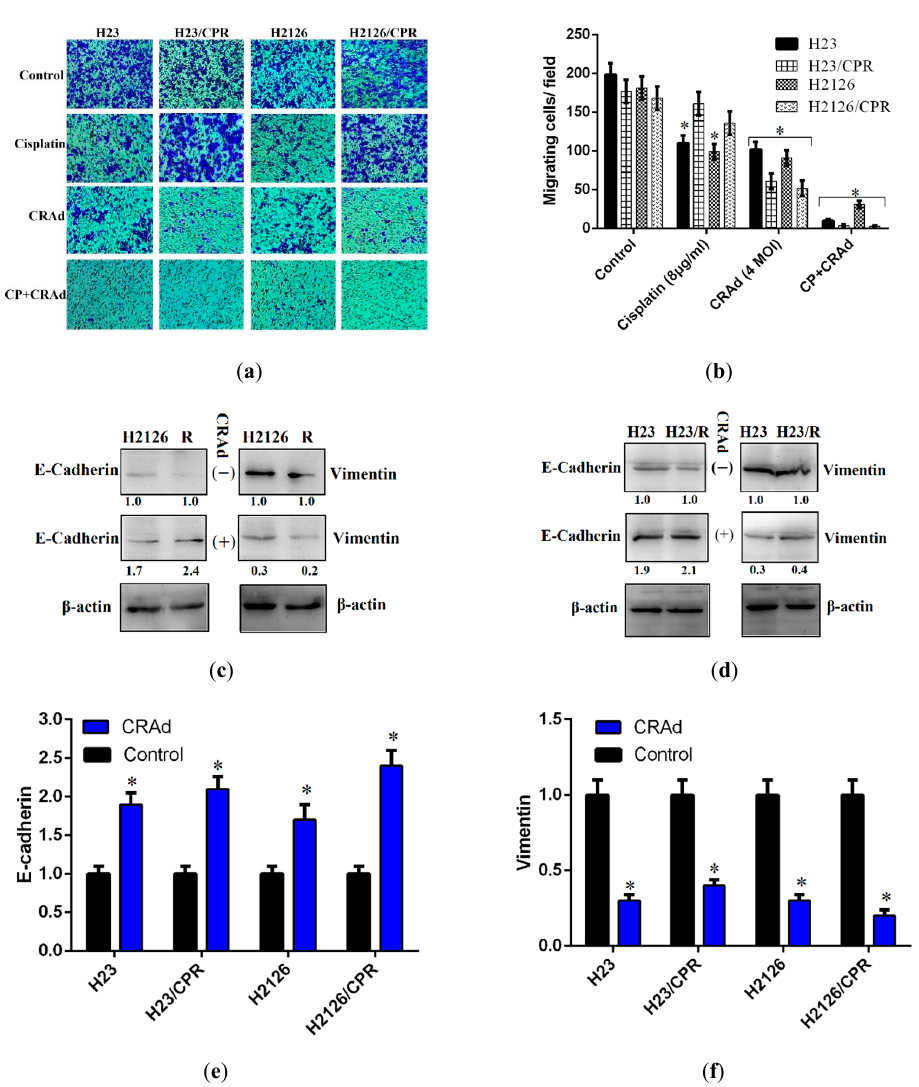
Figure 5. Tumor cell migration study via transwell assay: ( a ) Micrographs taken through a phase contrast microscope (100 × magnification) showing migrated cancer cells in three treatment groups and DMSO control. ( b ) Results show that CRAd monotherapy reduces the migrating cells to 100 as compared to 200 migratory cells in the control. Cisplatin monotherapy also inhibits the migration of cancer cells. However, the combination therapy exerts the most potent inhibition on cell migration. Data are presented as the mean ± SD ( n = 3), * p < 0.01, by two-tailed Student’s t -test. ( c – f ) Western blotting was performed to evaluate the expression of epithelial to mesenchymal transition markers. Total cell lysates were extracted and blotted with anti-E-cadherin, anti-vimentin antibodies, and resulting bands were normalized to the level of β -actin, and intensities were quantified relative to the untreated control as shown. Results show that compared to controls, protein levels of E-cadherin were increased while that of vimentin were decreased when cancer cells were treated with CRAd (* p < 0.01). The data shown above are the average of triplicate